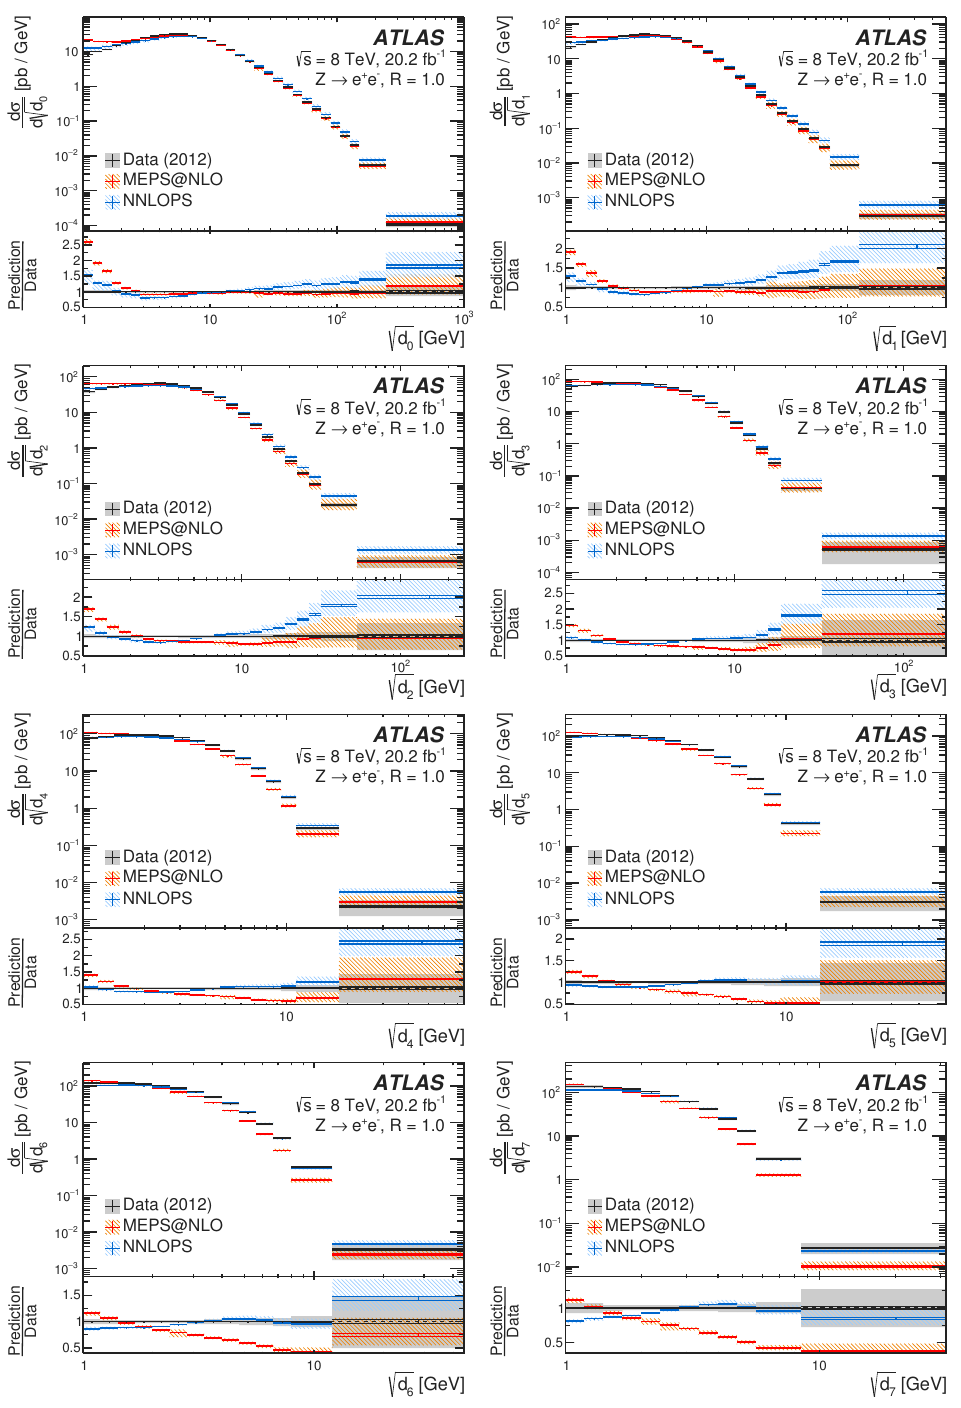
Figure 6. Charged-only distributions for the eight leading splitting scales in the electron chan- nel using the jet-radius parameter R = 1 : 0. The size of the error bars re(cid:13)ects the statistical uncertainty, while the combined statistical and systematic uncertainty is indicated by the grey band. Theoretical predictions from Sherpa with NLO multijet merging (\MEPS@NLO") and from Powheg + Pythia 8 with NNLO matching (\NNLOPS") are